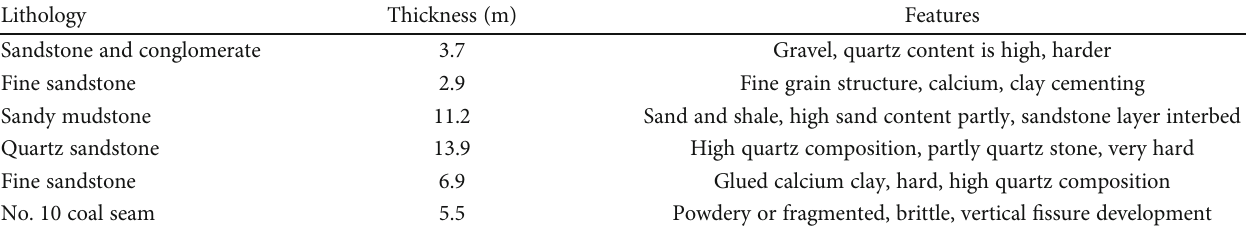
Table 1: Roof lithology of 1007 working